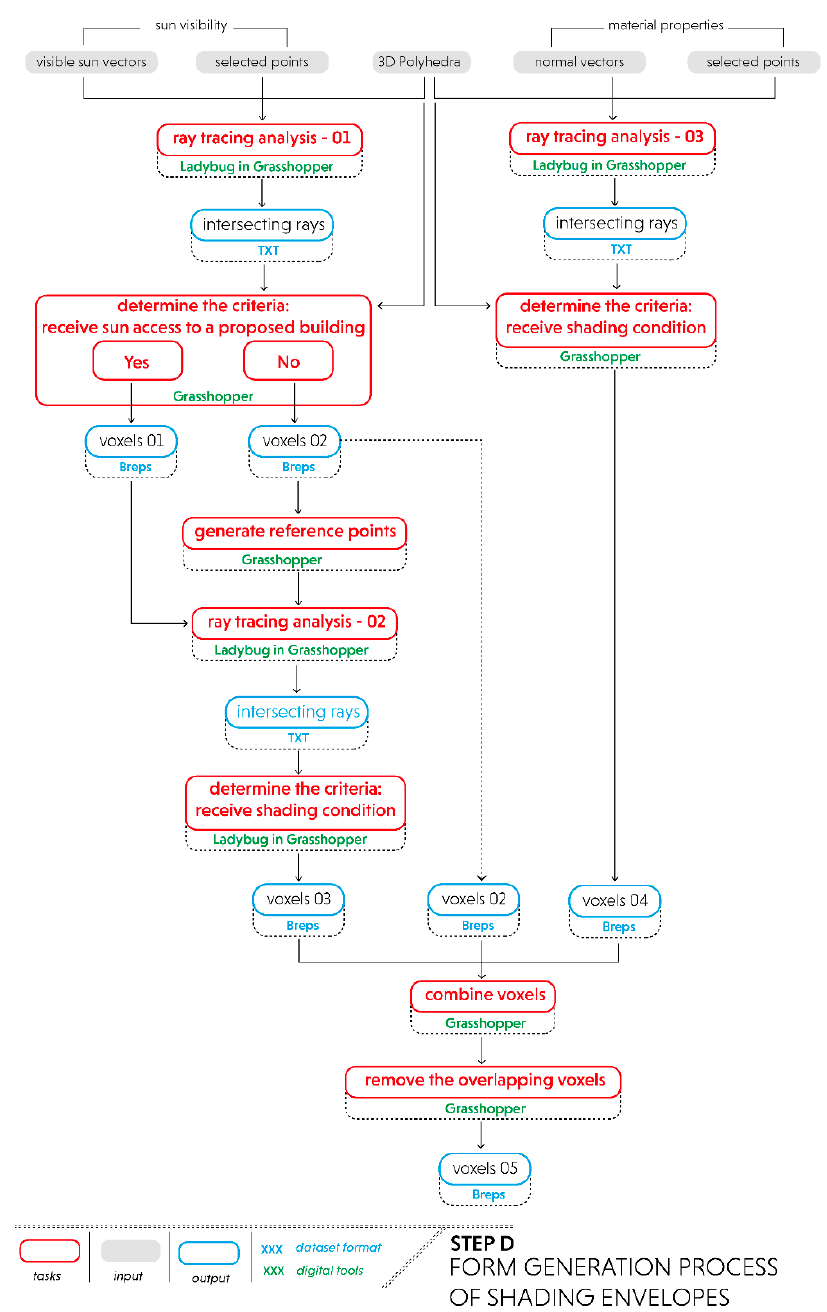
Figure 5. Detailed procedures for the design simulation.